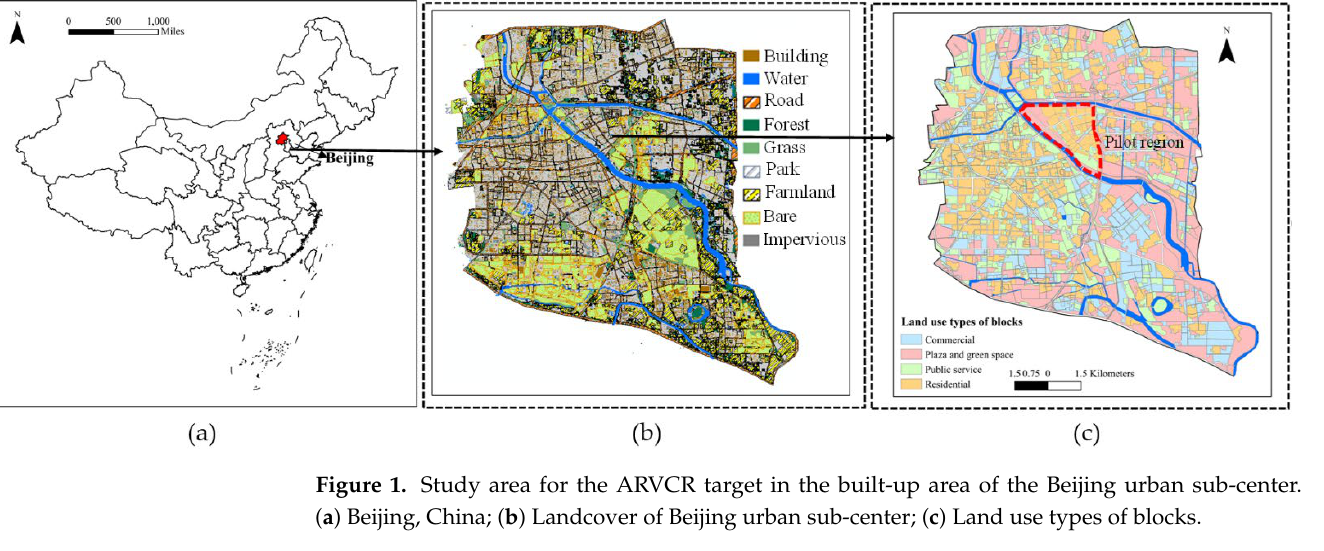
Table 1. Land cover by different types of land use in the whole study area.